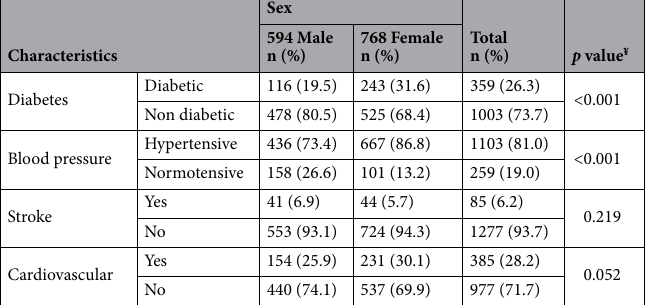
Characteristics Table 3. History of major non-communicable diseases amongthe community-dwelling older adults in Tabriz. ¥ p Value calculated by Chi-square test.